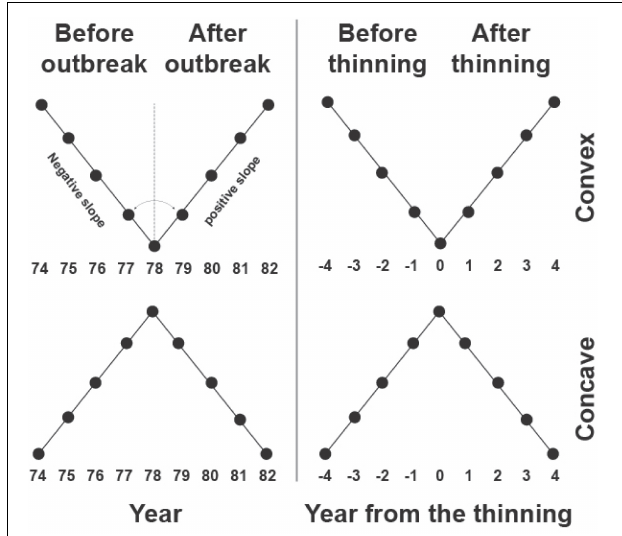
FIGURE 2 | Example of the segmented models used for identifying convex and concave growth patterns in tree-ring index during outbreak and